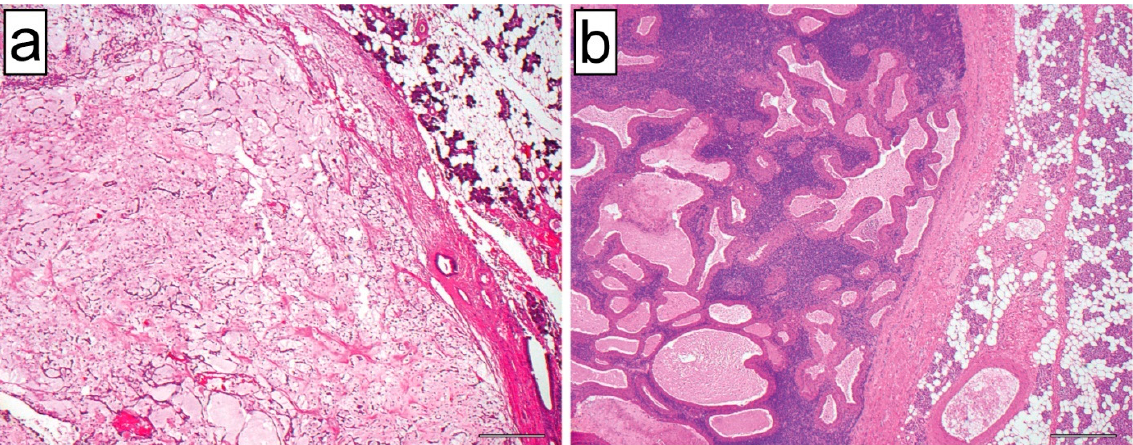
Figure 3. HE-stained examples of a pleomorphic adenoma ( a ) and a Warthin tumor ( b ) examined in this study (original magnification 40×; length of the scale bar: 50 µm). In both images, tumor-free salivary gland parenchyma is included on the right side of the image and a sharp demarcation of the benign tumor from the surrounding parenchyma can be seen.